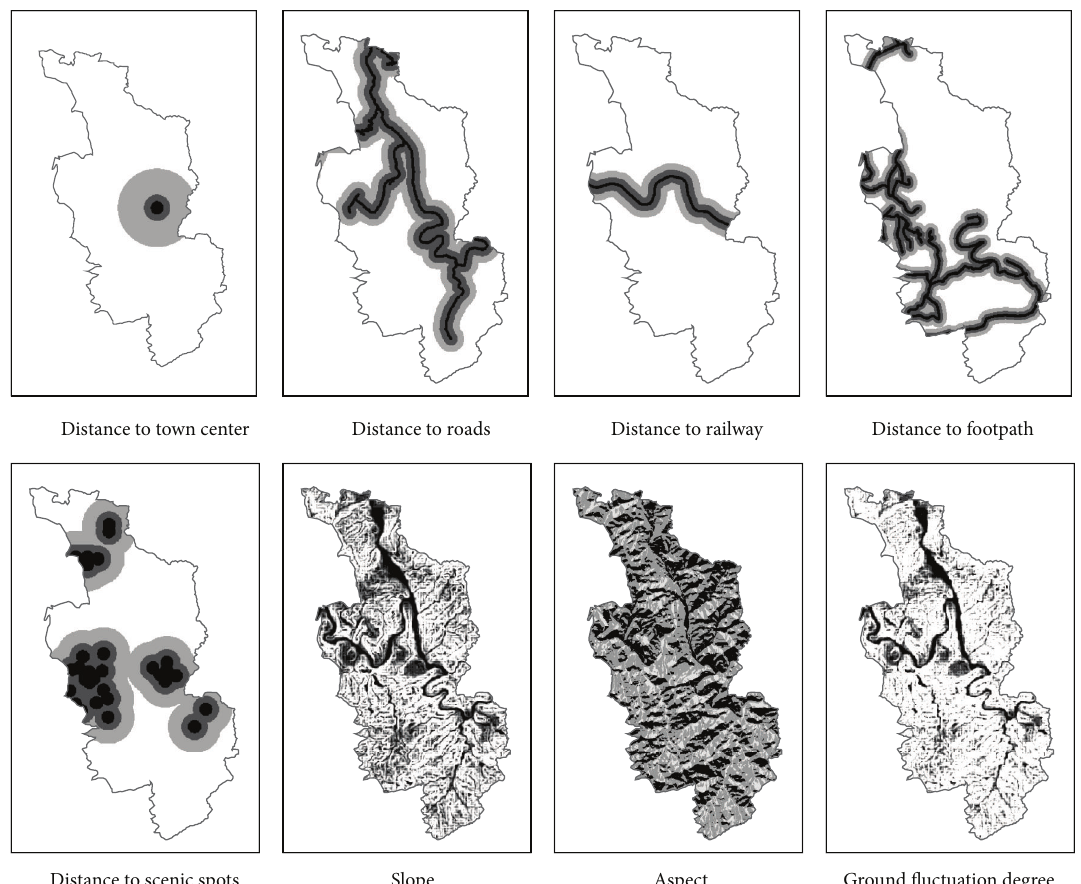
Figure 3: Spatio-temporal growth driving factors of tourist